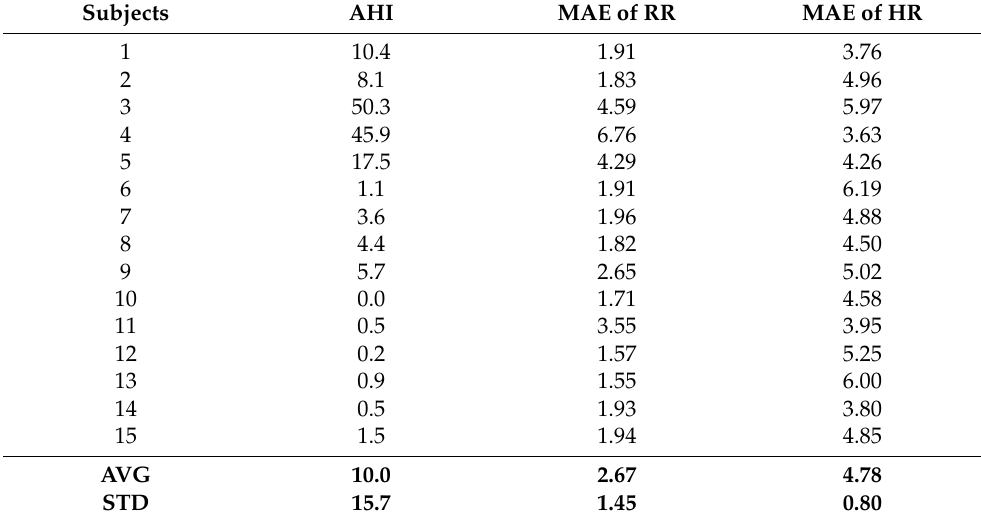
Table 3. MAE test results for each subject.